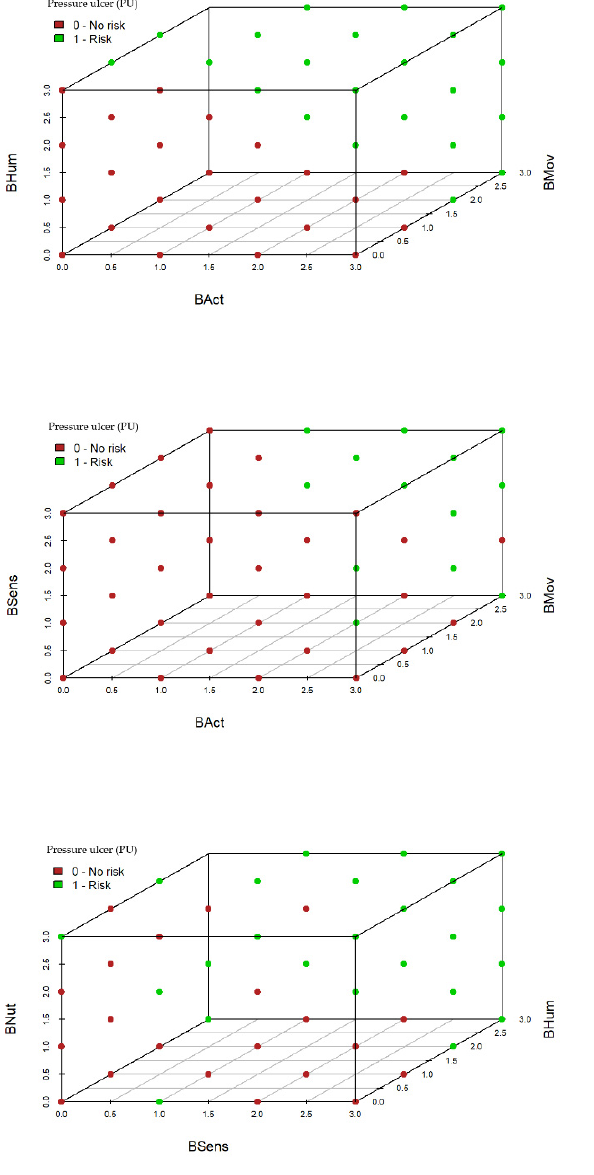
Figure 3. PU risk classification based on three subscales.